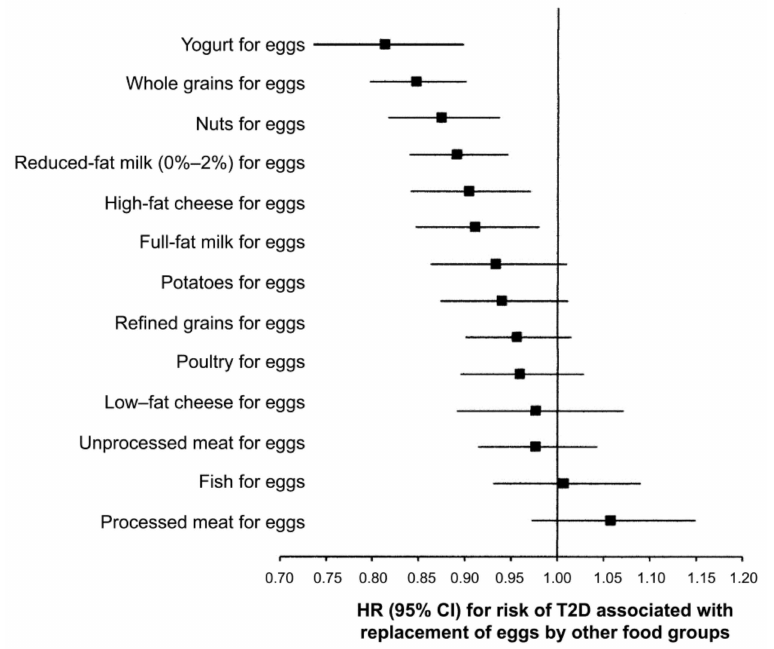
Figure 4. Statistical model-based hazard ratios (HRs) and 95% CIs for incident type 2 diabetes mellitus (T2DM) associated with replacing one egg/day with one serving/day of other foods in the NHS, the NHS II, and HPPS (pooled analysis, n = 213,798)